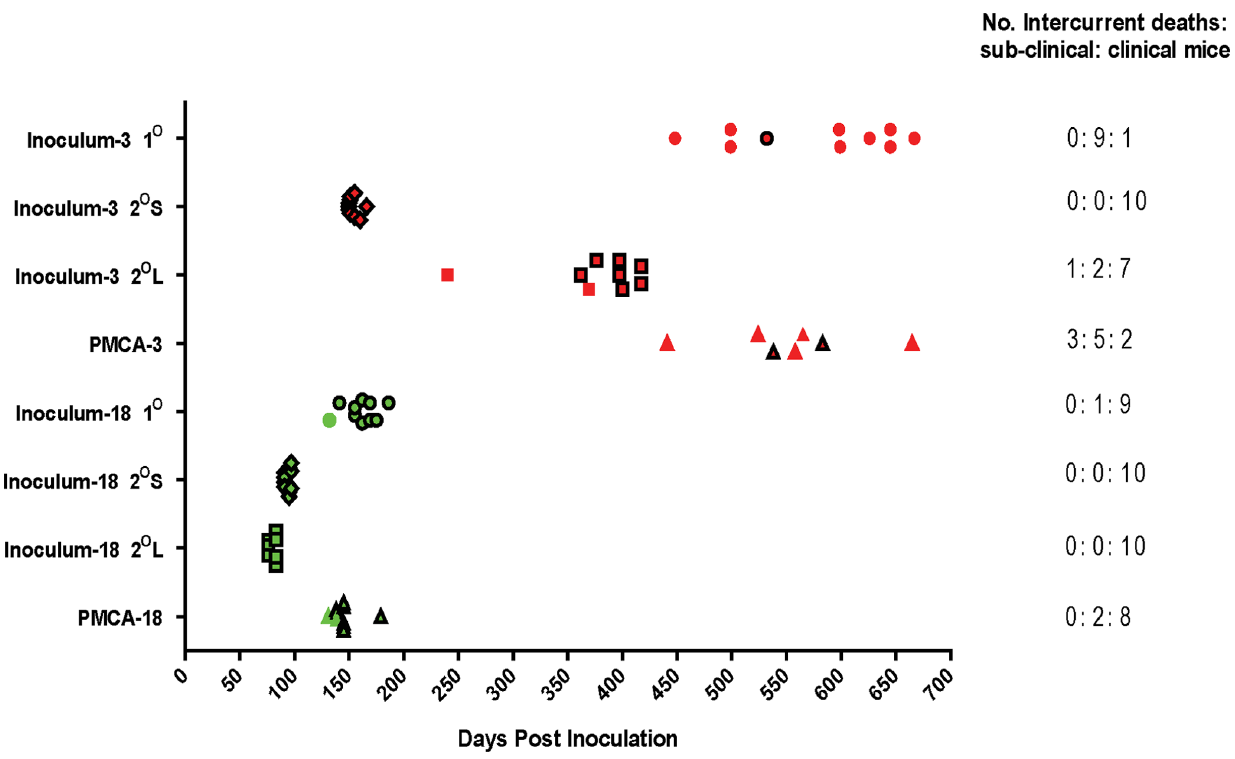
Figure 2. Incubation periods and attack rates of mice inoculated with non-amplified PrP Sc and corresponding PMCA products. Each inoculum was inoculated into 10 tg338 mice, each symbol representing an individual mouse. All TSE positive (histopathological and/or IHC positive) mice are included. Mice that died from intercurrent disease are not shown in the plot. Clinically positive mice are indicated by a black outline and were used to calculate incubation periods. Circles indicate 1 u , diamonds indicate 2 u S and squares indicate 2 u L passage of non-amplified ovine PrP. Triangles indicate mice inoculated with PMCA product. Red symbols denote mice inoculated with products originating from PG752/96 whilst green symbols denote mice inoculated with products originating from PG676/98. The number of mice that died due to intercurrent disease, the number of sub-clinical mice and the number of clinically positive mice are indicated next to each inoculum.